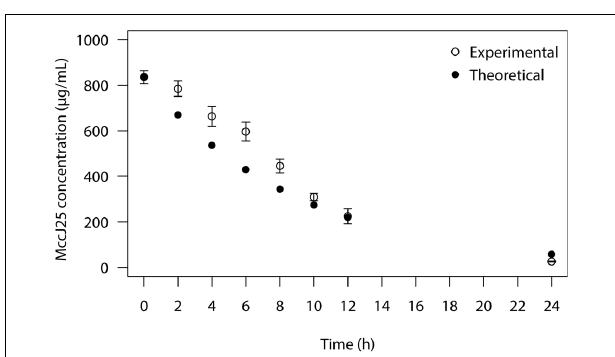
FIGURE 4 | Concentration of MccJ25 over 24 h colonic fermentation in the PolyFermS system based on LC-MS quantification. ( ◦ ) Experimental values measured during colonic fermentation based on the extracted ion peak areas obtained from the [M + 3H] 3 + ion of MccJ25 ( m/z 703.0); ( values calculated based on the dynamic flow in the PolyfermS system; measured values are means of two independent repetition